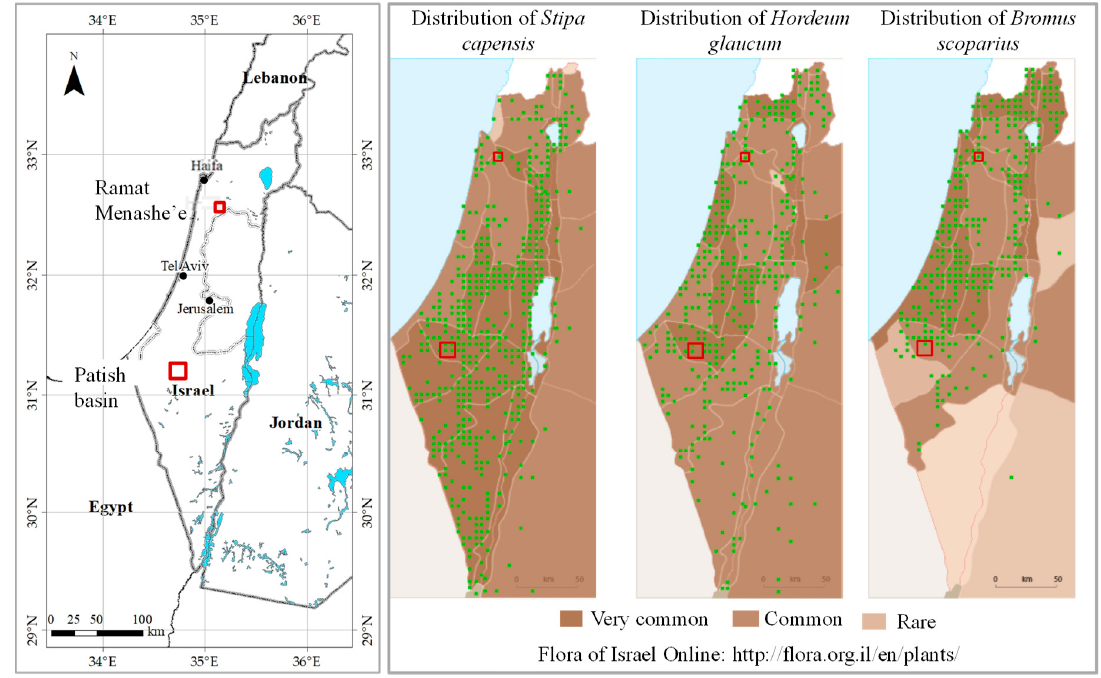
Figure 10. An example of the spatial distribution of annual species in Israel.